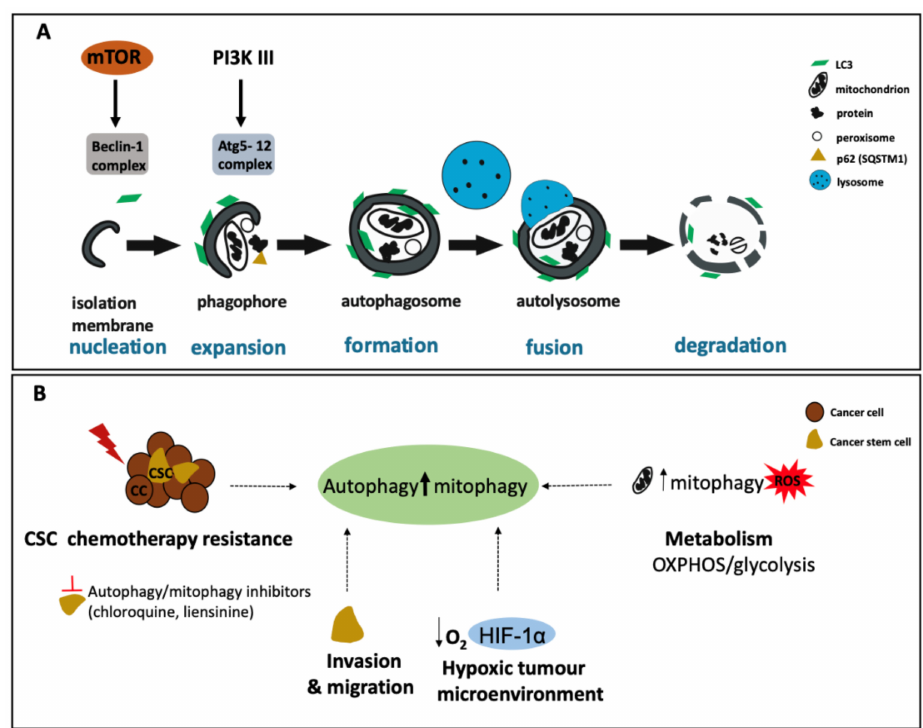
Figure 2. Autophagy, a pro-survival process, is elevated in CSCs. ( A ) The process of autophagy from nucleation to degradation. The process starts with the formation of an isolation membrane (regulated by the Beclin-1 complex), followed by the formation of a double membrane named the autophagosome which encapsulates cellular constituents for degradation. Following fusion with a lysosome, cell components in the autolysosome are degraded and recycled as nutrients and metabolites back into the cytosol. Several autophagy-related (Atg) proteins regulate different stages of autophagy (e.g., the Atg5-12 complex is vital for autophagosome formation). ( B ) Autophagy plays many roles in CSC survival. High levels of autophagy/mitophagy in CSCs promotes resistance to chemotherapy; potential treatments include autophagy/mitophagy inhibitors in combination with chemotherapy drugs. Induced autophagy stimulates CSC invasion and migration as well as survival in the hypoxic microenvironment. CSCs also depend on elevated mitophagy for their metabolism and to control ROS levels. Finally, CSCs show a mixed phenotype where both OXPHOS and glycolytic metabolism is employed in CSCs of different cancer